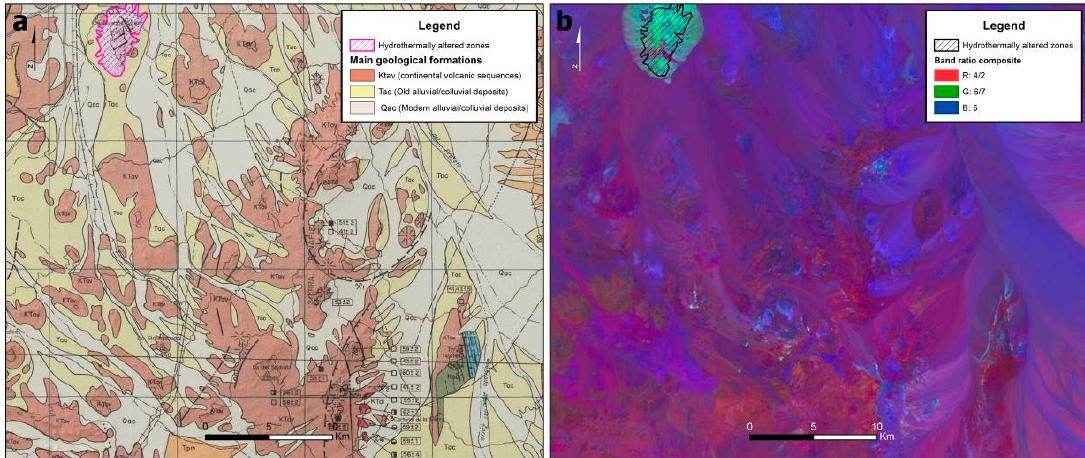
Figure 10. Comparison of: ( a ) 1:250.,000 geologic map [83]; and ( b ) 4/2, 6/7, 5 Landsat 8 RGB band ratio composite for a section in the northeastern portion of the study area. The hydrothermally-altered zone (green area) corresponds to the Buenos Aires hill.